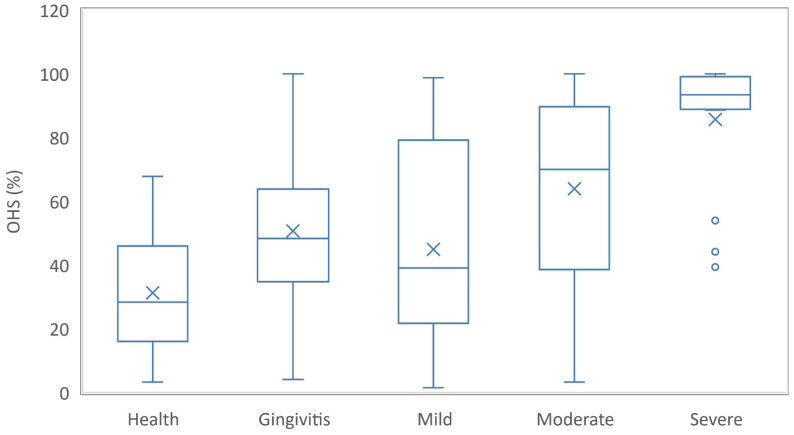
Oral Hygiene Score (OHS) distribution according to the group.